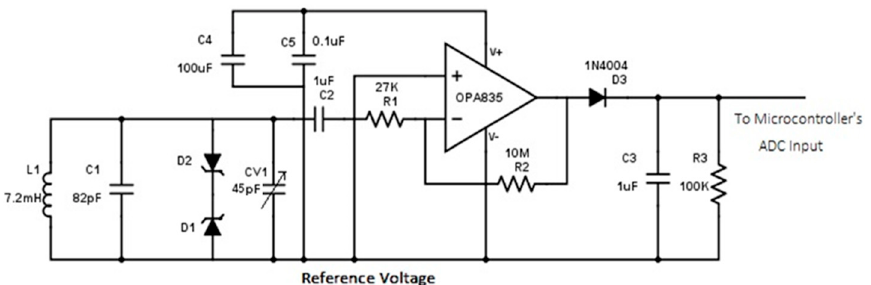
Figure 9. RF receiver circuit of the chest module.